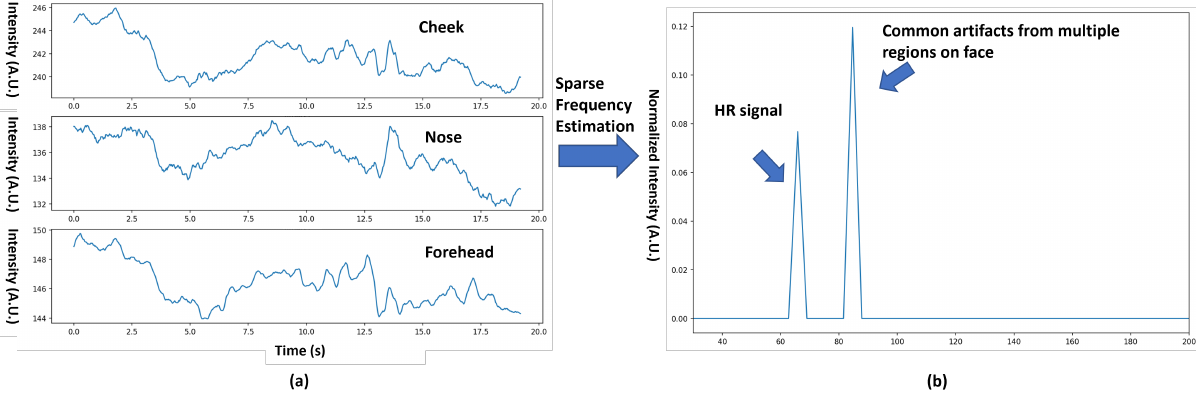
Figure 23. ( a ) Grayscale signal from three different ROIs on the face captured with the VCSEL illuminated ToF camera, showing similar patterns of artifacts among all three ROIs. ( b ) Extracted sparse frequency component using the method in [11], showing both HR and artifact frequency